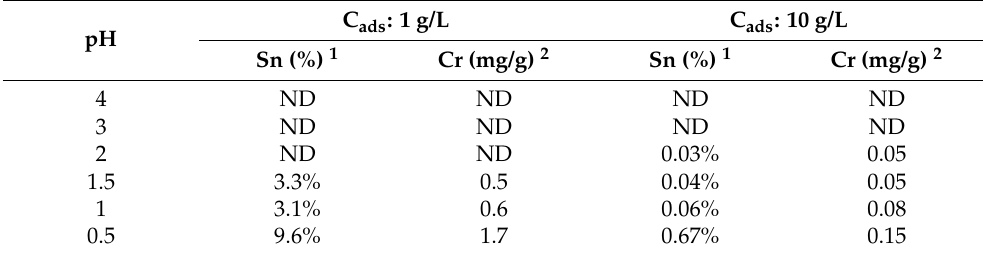
Table 3. Dissolved Sn and Cr in relation to dissolution pH for different adsorbent concentrations (acid: HCl, T: 25 ◦ C, t = 30 min).